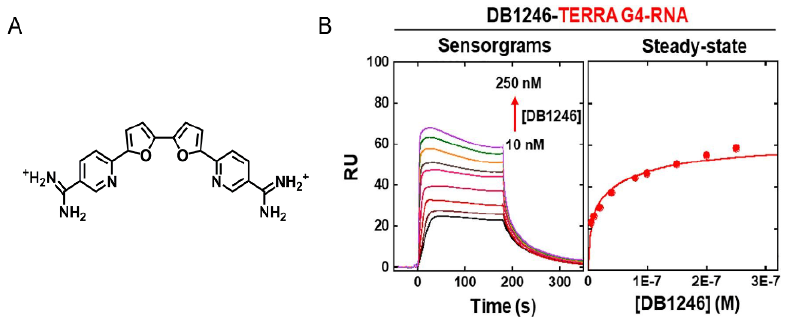
Figure 17. ( A ) Sensorgrams with increasing concentrations of the diamidine derivative DB1246. ( B ) Binding curve showing a two-site binding model with K D1 = 3 ± 0.8 nM and K D2 = 80 ± 12 nM. For the immobilization procedure, ~100 μ L of 25 nM of TERRA G4 were prepared in HBS-EP buffer (10 mM HEPES pH 7.4, 150 mM NaCl, 3 mM EDTA, 05% v / v polysorbate 20). The compound DB-1246 (300 μ L) was injected in the system from low (10 nM) to high concentration (250 nM). Reprinted with permission from ref. [173] Copyright 2019 Elsevier.